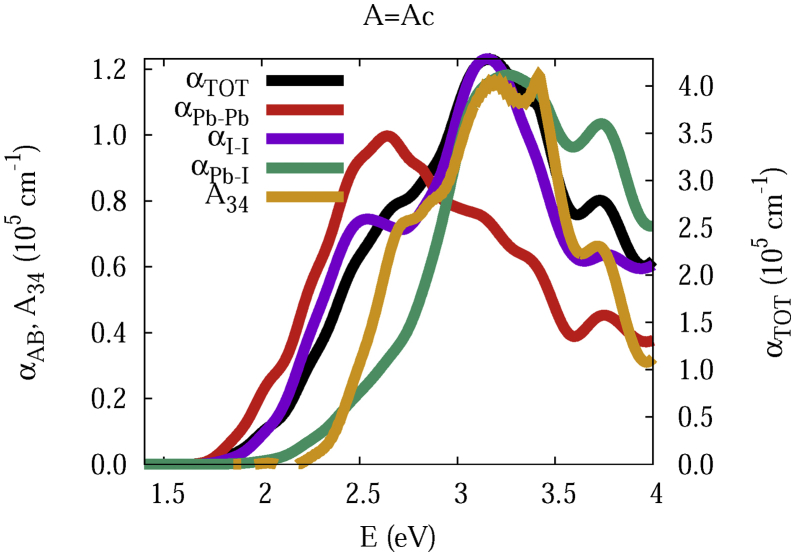
Same legend as that in Fig. 1, but for A = Ac.